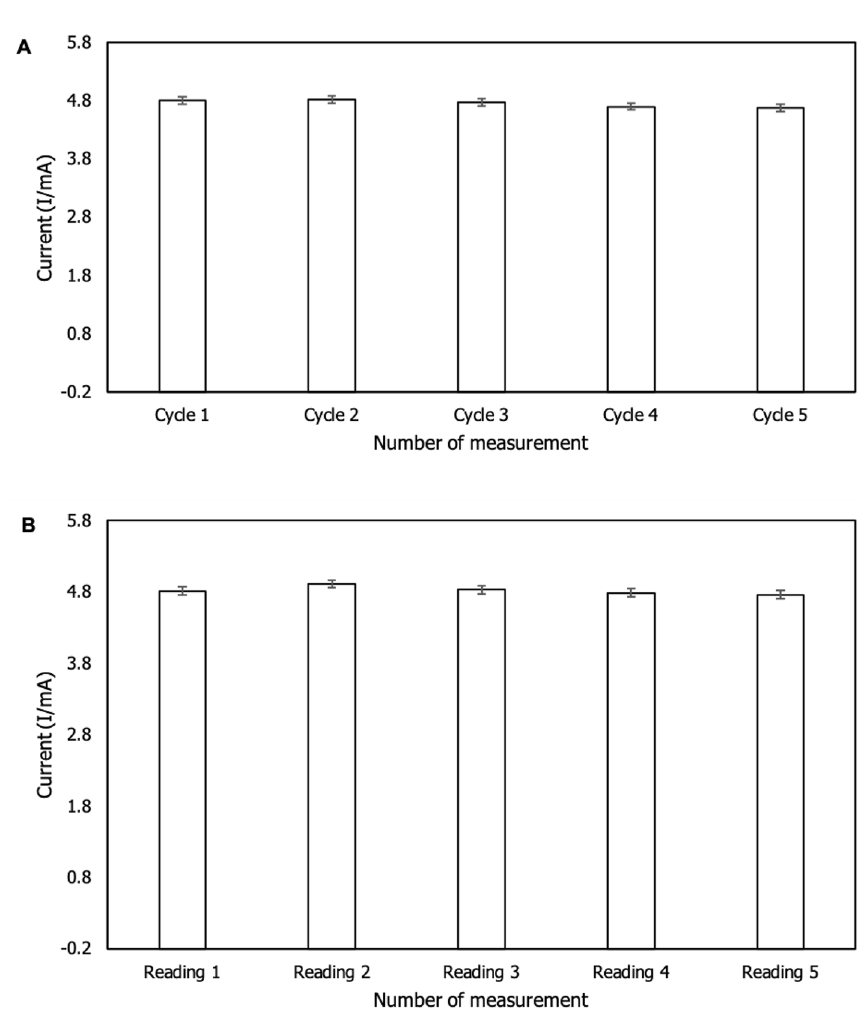
Figure 10. Bar charts of ( A ) repeatability and ( B ) reproducibility tests on f-MWCNTs/CS/PB/AuE in the presence of Zn 2+ ( n = 5).